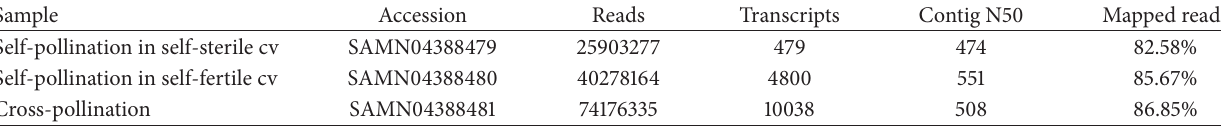
Table 1: Total used reads and total assembled transcripts and statistics for analysed